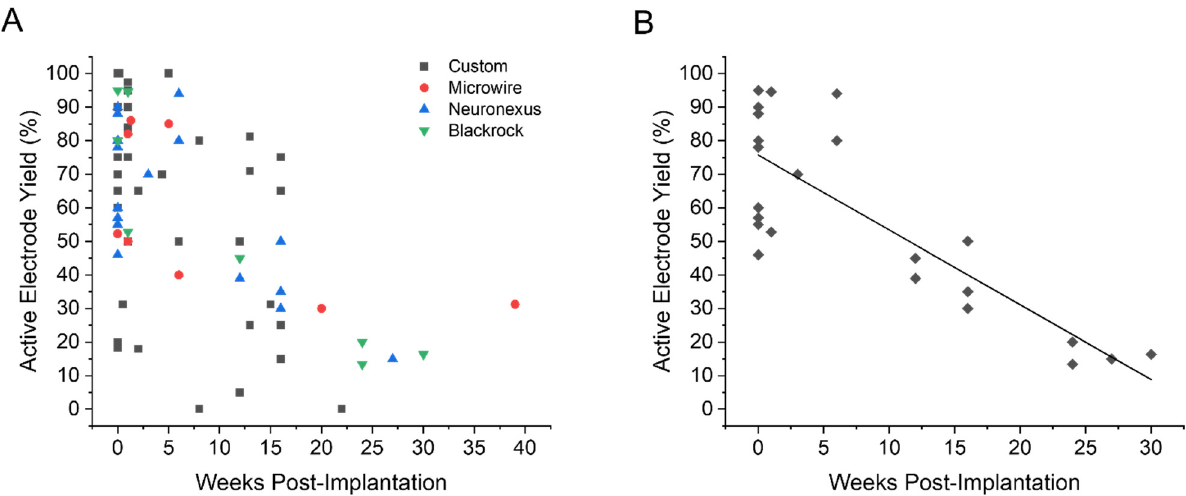
Figure 3. Active electrode yield over time. ( A ) A scatterplot of initial and final active electrode yield percentages for Custom (black square), Microwire (red circle), Neuronexus (blue triangle), and Blackrock (green inverted triangle) as reported by the original studies. ( B ) Curve fitting of a scatterplot consisting of commercially-fabricated devices (Neuronexus and Blackrock). The curve resulted in an initial AEY value of ~75% and slope of –2.2 percent/week with adjusted R 2 and Pearson’s R values of 0.67 and –0.83 respectively. Data used to create Figure 3 was extrapolated from the references as follows: Custom [16,30,32,51,52,55,61,62,71,84,88,92], Microwire [58,63,81,82], Neuronexus [24–27,44,68,91], Blackrock [29,98,99,103]